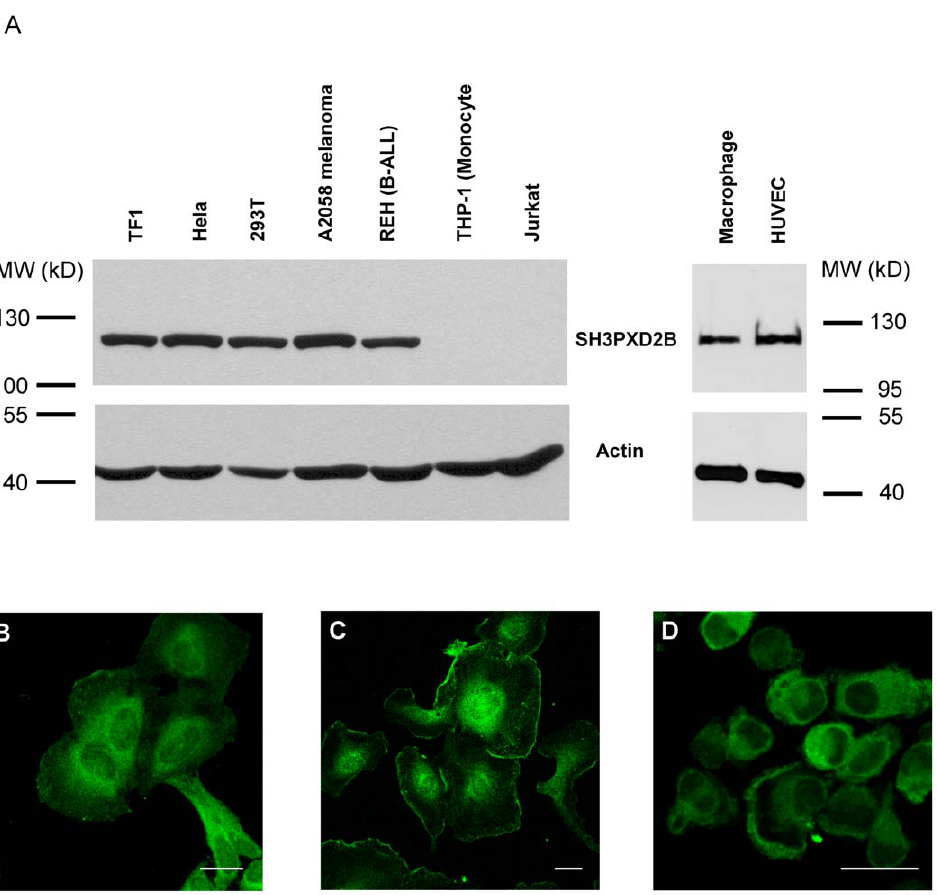
Figure 1. Expression of SH3PXD2B in various human cell lines and primary cells. ( A ) Expression of the SH3PXD2B protein in various transformed cell lines (left panel), macrophages and HUVEC (right panel). SH3PXD2B was detected by the affinity purified antibody described in Materials and Methods. Actin was used as a loading control. ( B–D ) Intracellular localization of SH3PXD2B. SH3PXD2B protein in HeLa cells ( B ), in HUVECs ( C ) and in primary human macrophages ( D ) was visualized by immunofluorescence. Cells were grown on coverslips and processed as detailed in Materials and Methods. Bars indicate 20 m m.